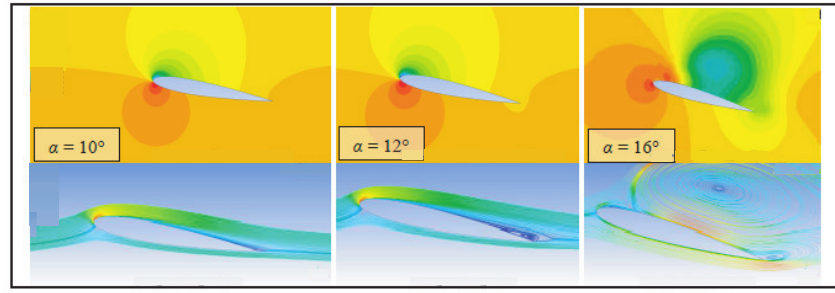
Figure 29. Pressure contours and streamlines at Re = 1.5 × 10 5 .